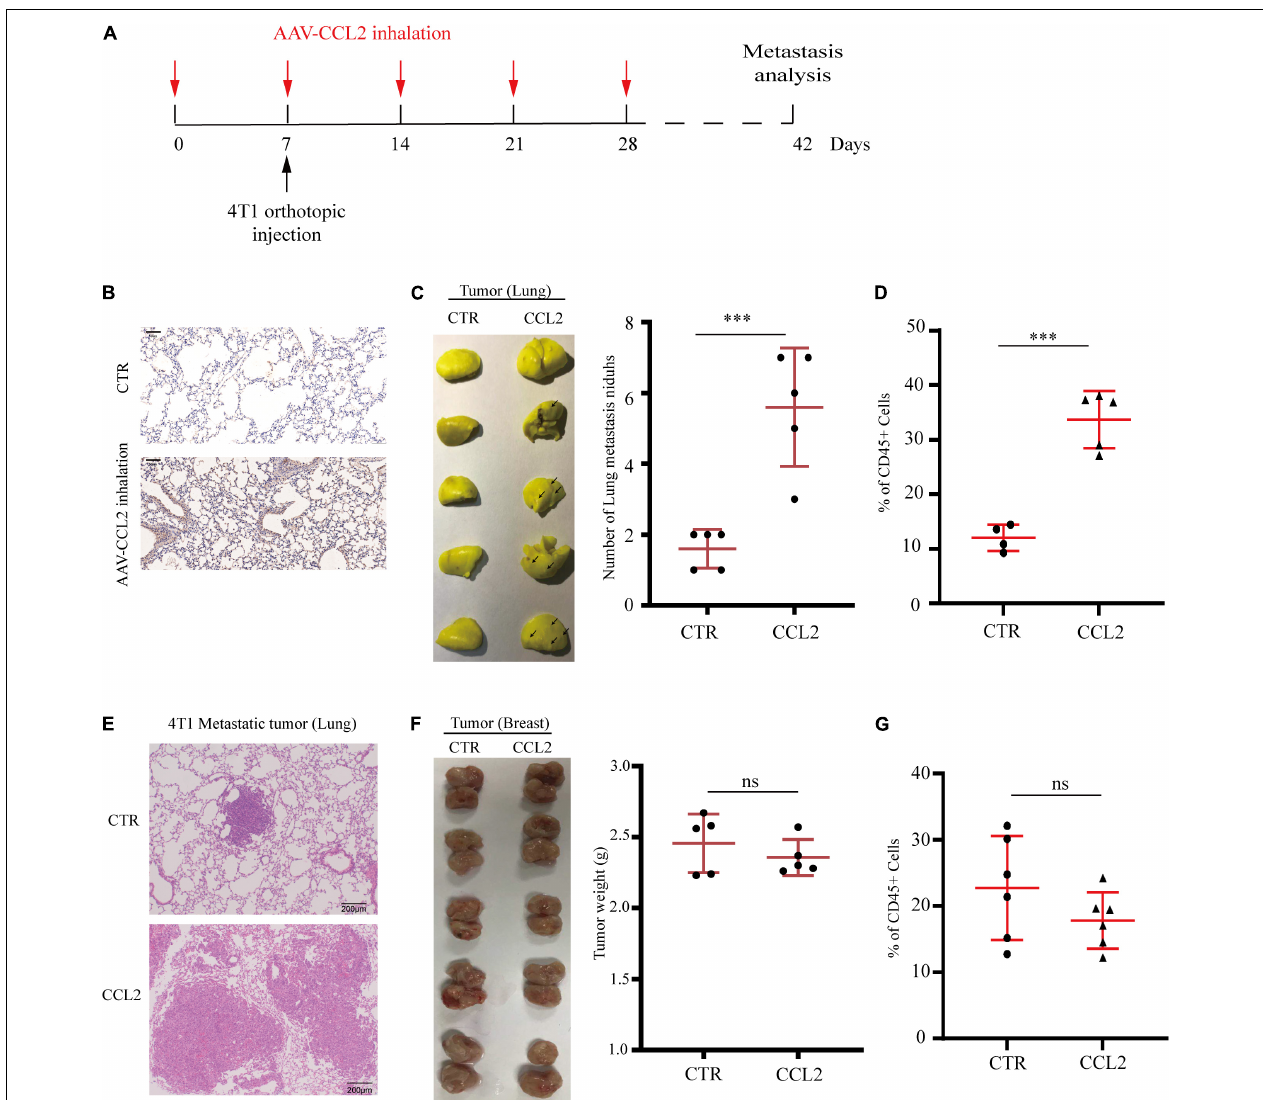
FIGURE 2 | Specific expression of CCL2 in lung facilitates breast cancer metastasis. (A) Schematic illustration for the in vivo delivery of adenovirus-mediated CCL2 overexpression in lung and spontaneous lung metastasis analysis. (B) Representative immunohistochemical staining for CCL2 after AAV-CCL2 inhalation. Bar = 50 µ m (magnification: 200 × ). (C) Photography of lung metastasis nidus (left) and lung metastasis nidus counts (right) in both normal and lung-specific CCL2 overexpression tumor-bearing mice was counted after fixed and stained with Bouin’s solution ( n = 5). (D) Analysis of MDSCs recruitment in the metastasis lung tumor of both normal and lung-specific CCL2 overexpression tumor-bearing mice by FACS ( n = 5). (E) Representative hematoxylin-eosin staining of lung metastasis tumor after CCL2 overexpression in lung. Bar = 200 µ m (magnification: 100 × ). (F) Photography of orthotopic breast tumor (left) and tumor weight (right) in the mammary gland of normal and lung-specific CCL2 overexpression mice ( n = 5). (G) Analysis of orthotopic breast tumor infiltration MDSCs in both normal and lung-specific CCL2 overexpression mice ( n = 5). P values were calculated by unpaired Student’s t -test (*** P <